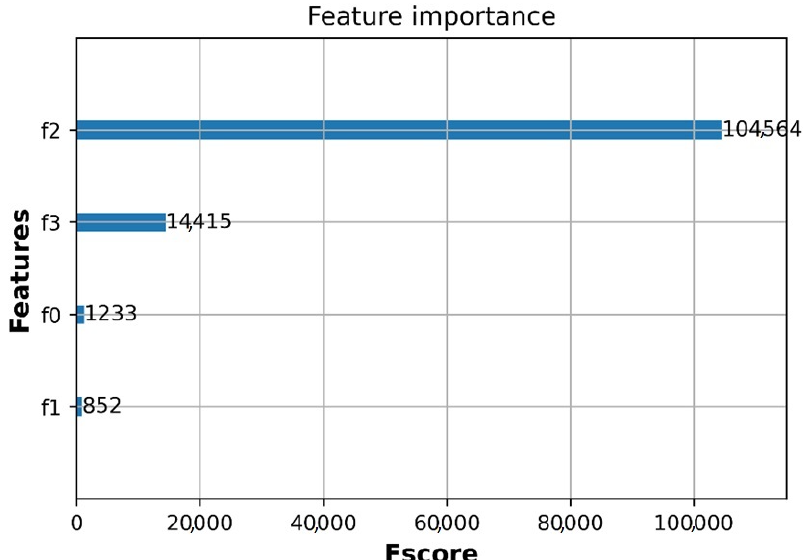
Figure 6. Feature importance using XGBoost algorithm.